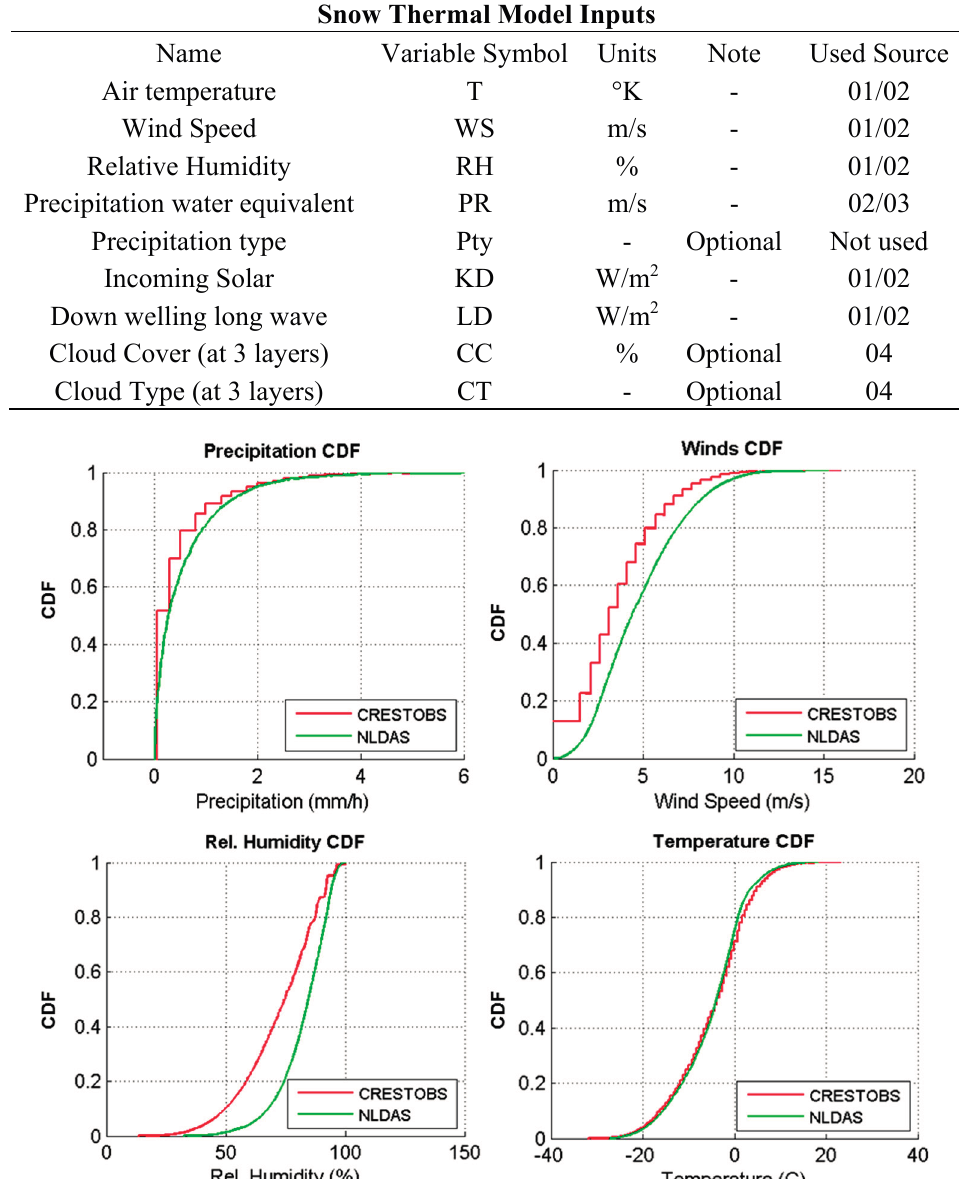
Table 1. SNTHERM model inputs list and sources. Source 01 is CREST-SAFE observed meteorological data, Source 02 is NLDAS data, Source 03 is a national weather service station, and Source 04 is the National Climatic Data Center (NCDC) FM Report.